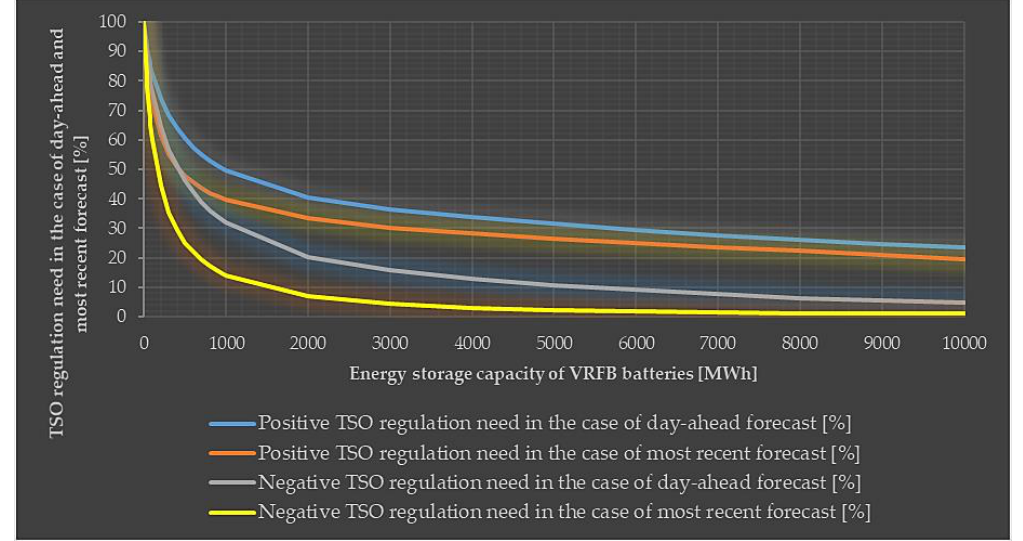
Figure 14. The relationship of negative and positive TSO regulation needs in the case of day-ahead and most recent forecast with different VRFB energy storage capacities related to a 1000 MWp PV system for the period of 30/09/2014–30/09/2019.